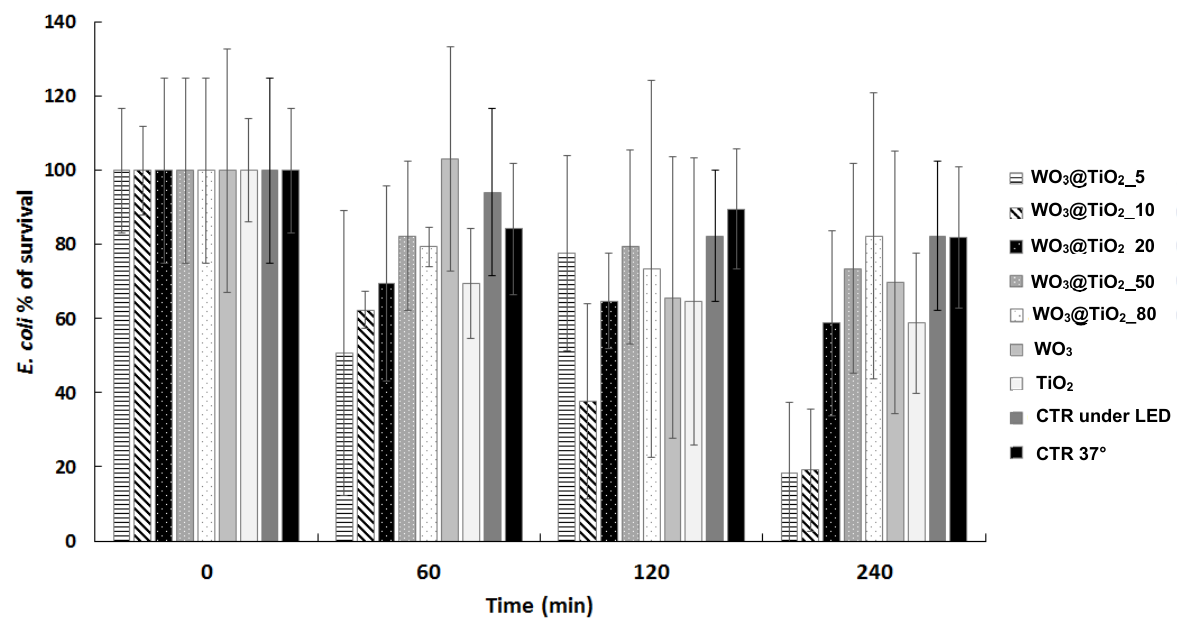
Figure 9. Percentage of E. coli cell survival after exposure to visible light in the presence of the synthesized heterostructures.